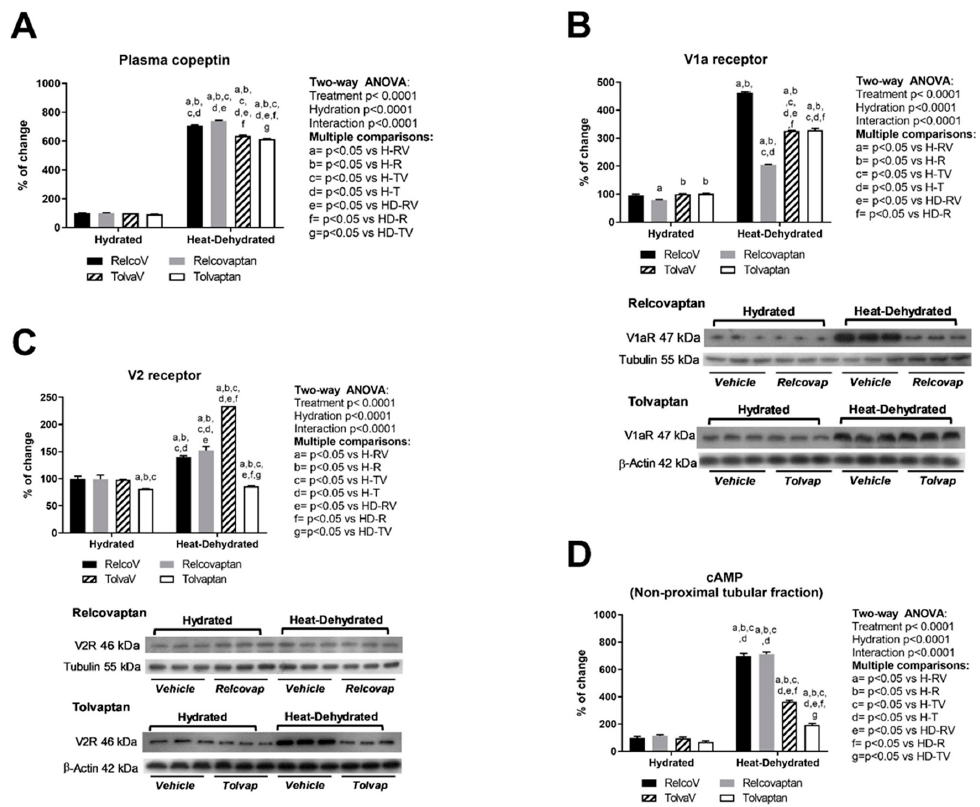
Figure 2. Plasma copeptin and vasopressin receptors expression in the renal cortex. ( A ) Plasma by heat stress and fructose beverage rehydration. Relcovaptan partially prevented V1a overexpression ( B ), and tolvaptan fully prevented V2 overexpression ( C ). ( D ) Likewise, only tolvaptan prevented the increment of cAMP in the non-proximal tubule fraction induced by heat stress and rehydration with the fructose beverage. For western-blotting, three random samples per group were selected. Proteins of interest and the respective loading controls were run independently at the same time using the same conditions. The raw dataset is available in the Supplementary